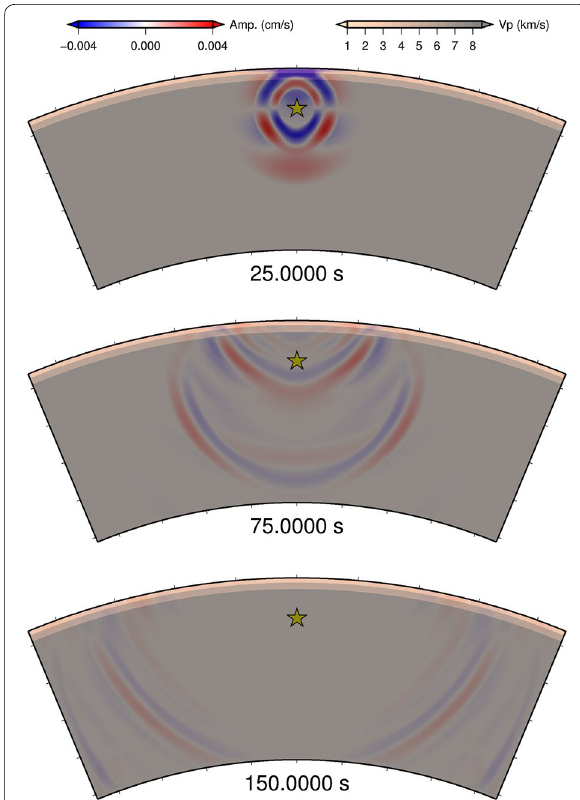
Fig. 7 Snapshots of elastic wave propagation for a vertical cross sec- tion through the source ( yellow star ) and the receivers shown in Fig. 6